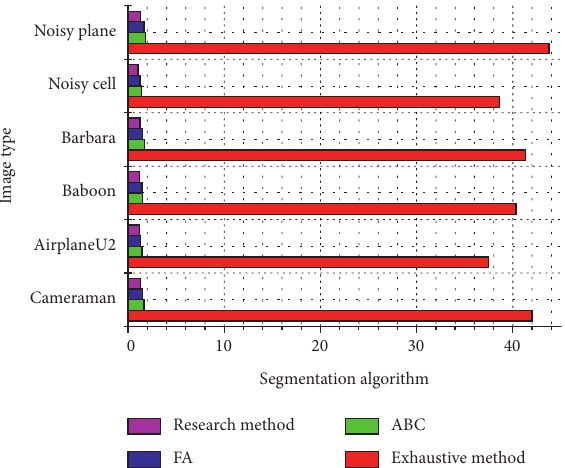
Figure 4: Comparison of computation